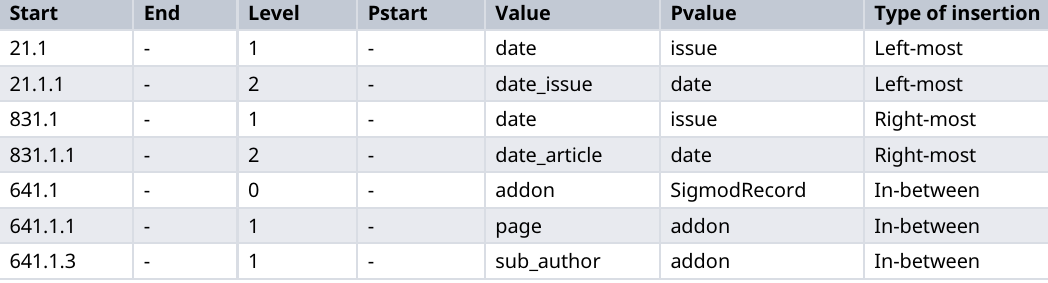
Table 3. iTable of Parent Table for dynamic updates.